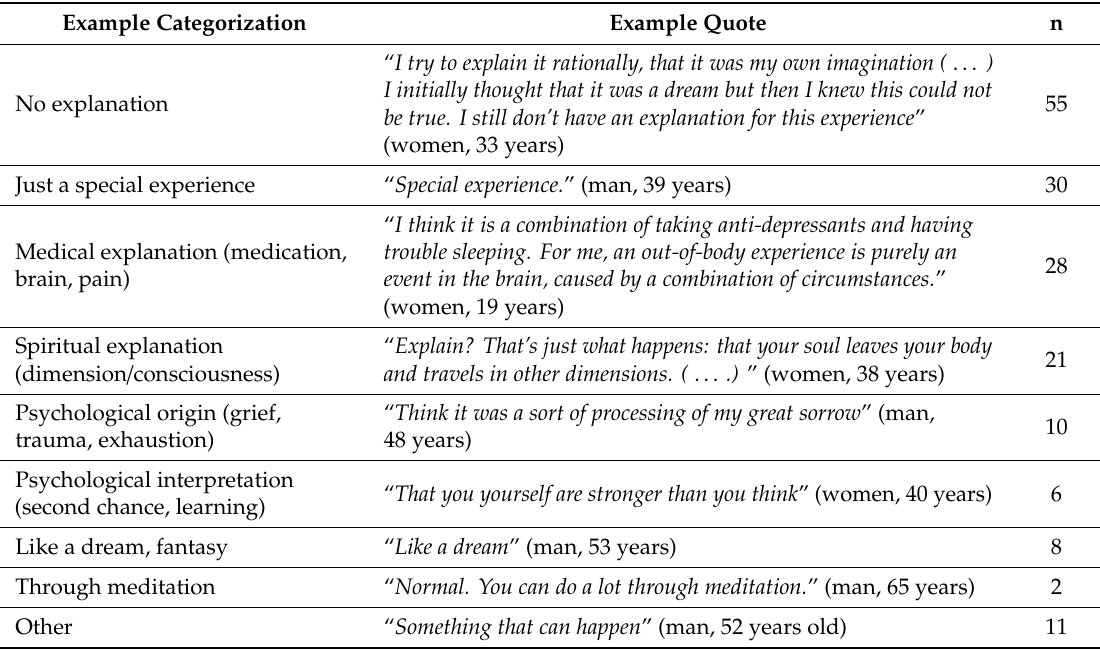
Table 5. (How) do you explain your OBE? (n =